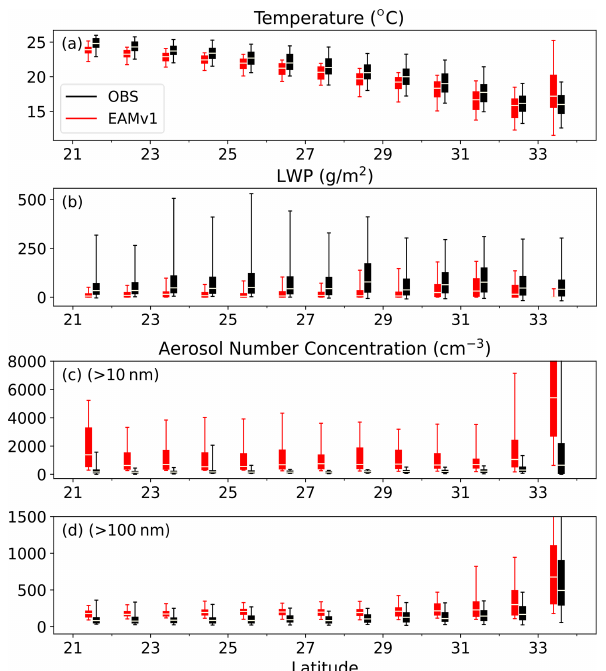
Figure 14. Percentiles of (a) air temperature, (b) grid-mean liq- uid water path (LWP), (c) aerosol number concentration for di- ameters > 10nm, and (d) aerosol number concentration for diam- eters > 100nm for all ship tracks in MAGIC binned by 1 ◦ latitude bins. The percentile box represents the 25th and 75th percentiles, and the bar represents the 5th and 95th percentiles. The observed aerosol number concentrations for diameters > 10 and > 100nm are obtained from CPC and UHSAS, respectively.